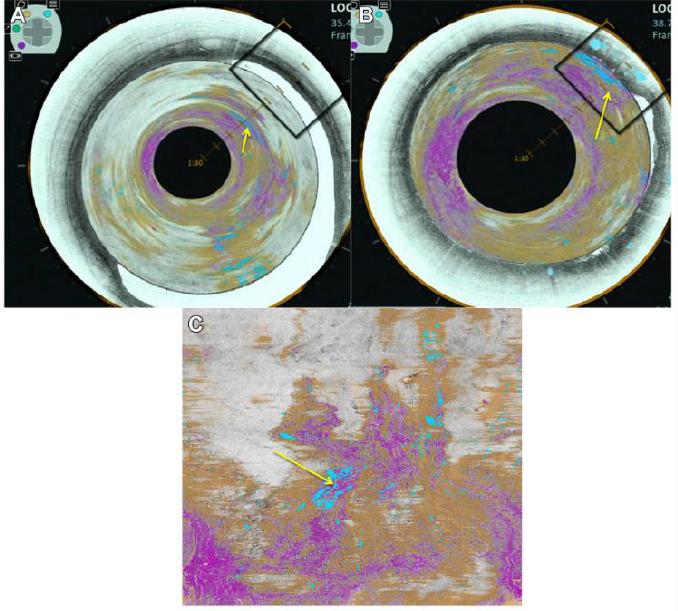
Figure 7. Esophagus image of the OCT showing a luminal en face view of an area of overlap (yellow arrow) between the three features of dysplasia (orange is lack of layering, blue is glandular structures and pink is a hyper-reflective surface). ( A ) A view looking down from the proximal esophagus. ( B ) A view closer to the suspected area of dysplasia. The en face view is also shown ( C ) [112].